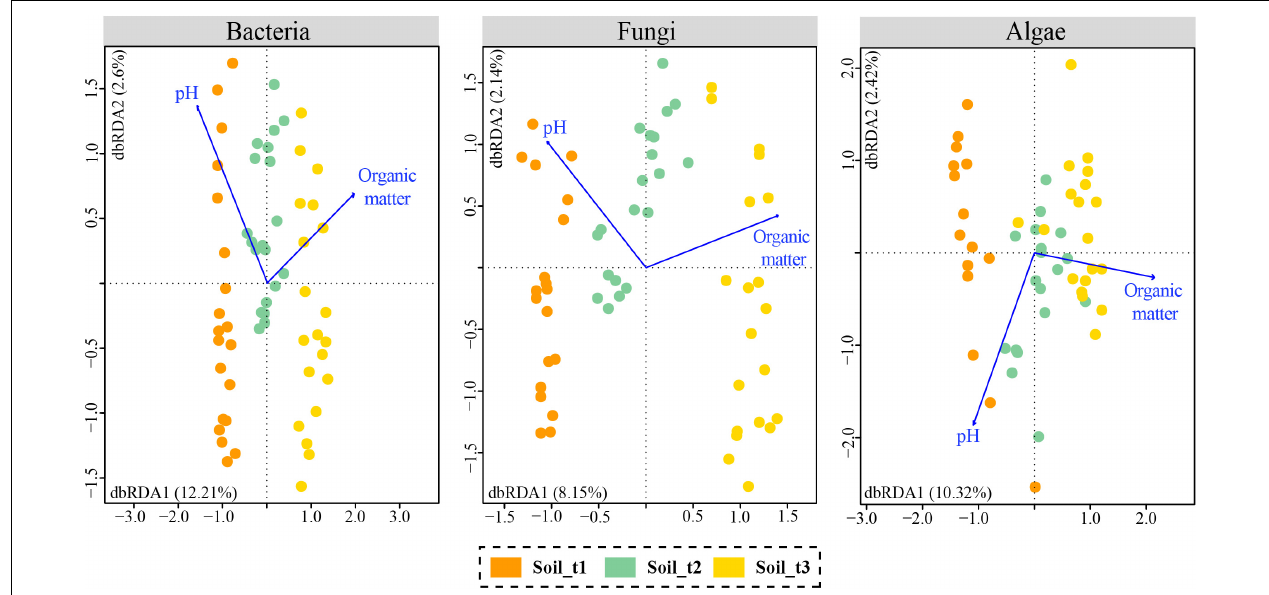
FIGURE 5 | Distance based redundancy analyses (db-RDAs) with selected edaphic variables that explained most of the variability in soil communities of bacteria, fungi and algae. Samples of each of the three successional stages are colored